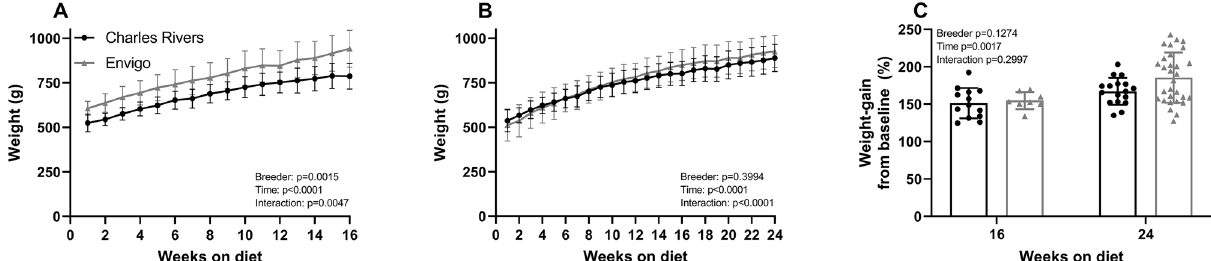
Figure 1. Body weight and relative weight-gain. ( A ) Bodyweights were higher for guinea pigs fed a high fat diet from Envigo compared with Charles River from week 1 to 16. ( B ) Bodyweights did not differ between